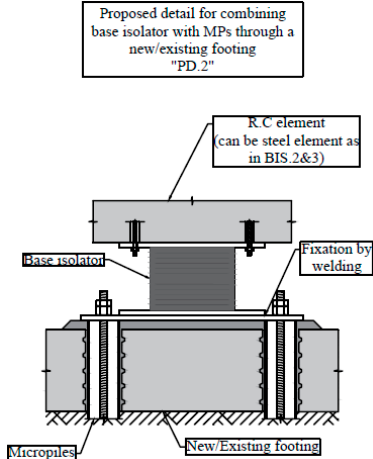
Figure 14. New proposed detail for combing MPs with BIS (new reinforced concrete footing).